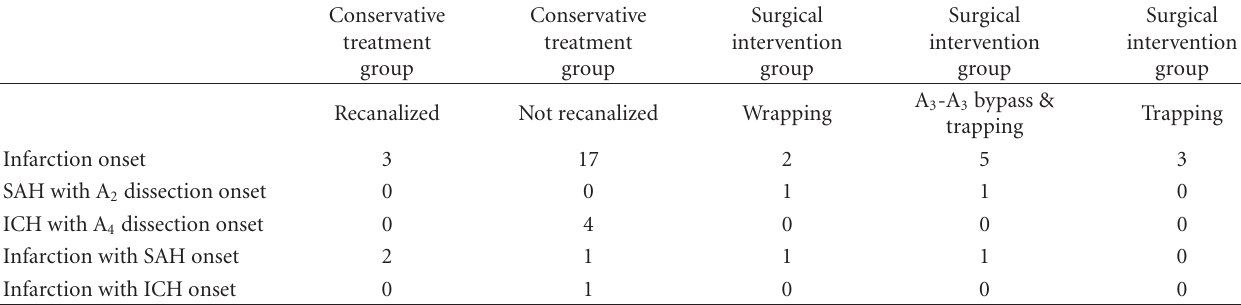
Infarction with SAH onset Infarction with ICH onset